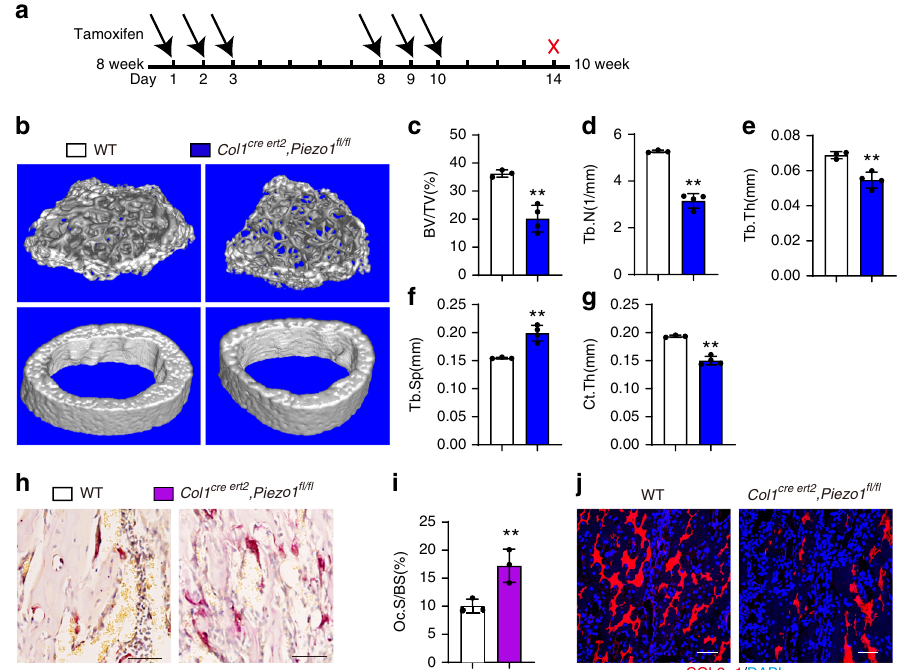
Fig. 7 Sudden loss of Piezo1 in osteoblast lineage cells decreased the bone mass. a Scheme of the experiment: male WT and Col1 Cre ert2 , Piezo1 fl / fl mice were injected with tamoxifen (0.1 g/kg) at 8-week-old and sacri fi ced for analysis at 10-week-old. b 3D μ -CT images of trabecular bones of distal femurs. c – g μ -CT analysis of distal femurs for bone volume per tissue volume (BV/TV) ( c ), trabecular number (Tb.N) ( d ), trabecular thickness (Tb.Th) ( e ), trabecular spacing (Tb.Sp) ( f ) and cortical thickness (Ct.Th) of middle shaft of femurs ( g ). Data are mean ± SD, WT, n = 3, CKO, n = 4. h TRAP staining of the femurs isolated from 10-week-old male WT and Col1 Cre ert2 , Piezo1 fl / fl mice. Scale bar = 50 μ m. i Quanti fi cation of the TRAP staining by osteoclast surface per bone surface (Oc.S/BS). Data are mean ± SD, n = 3. j Immuno fl uorescence assay of COL2 α 1 of 10-week-old male WT and Col1 Cre ert2 , Piezo1 fl /